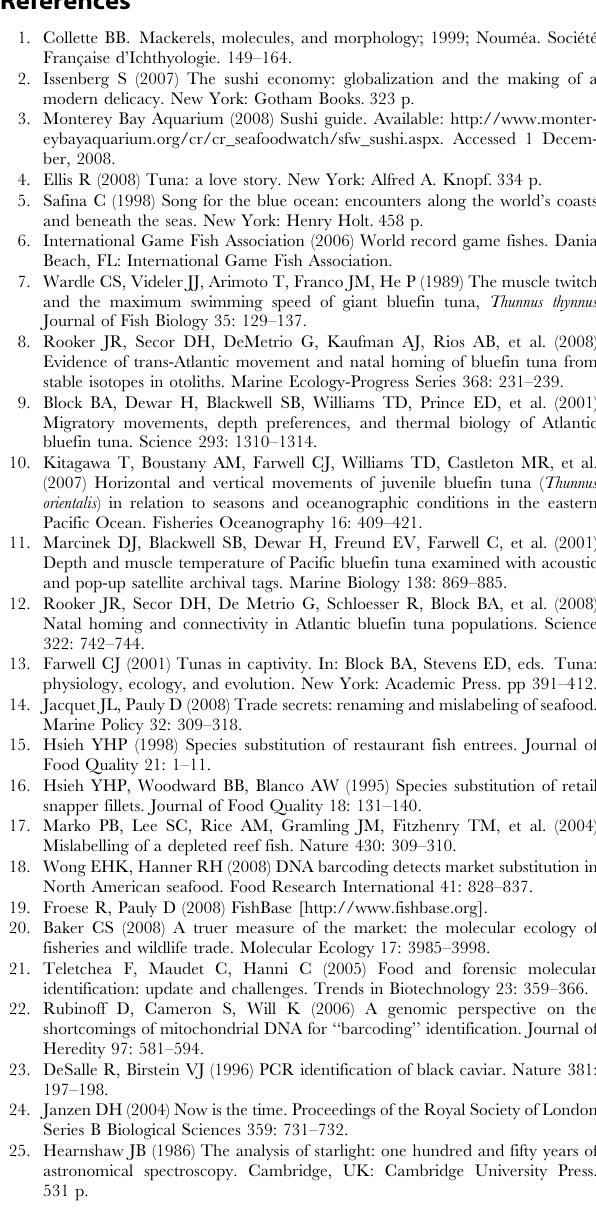
Figure S1 Alignment comprising all publicly available sequence records available for blackfin ( Thunnus atlanticus ) and bigeye tuna ( T. obesus ) in GenBank and the Barcode of Life Database. Sequence DQ835863.1 appears to be either a case of introgression